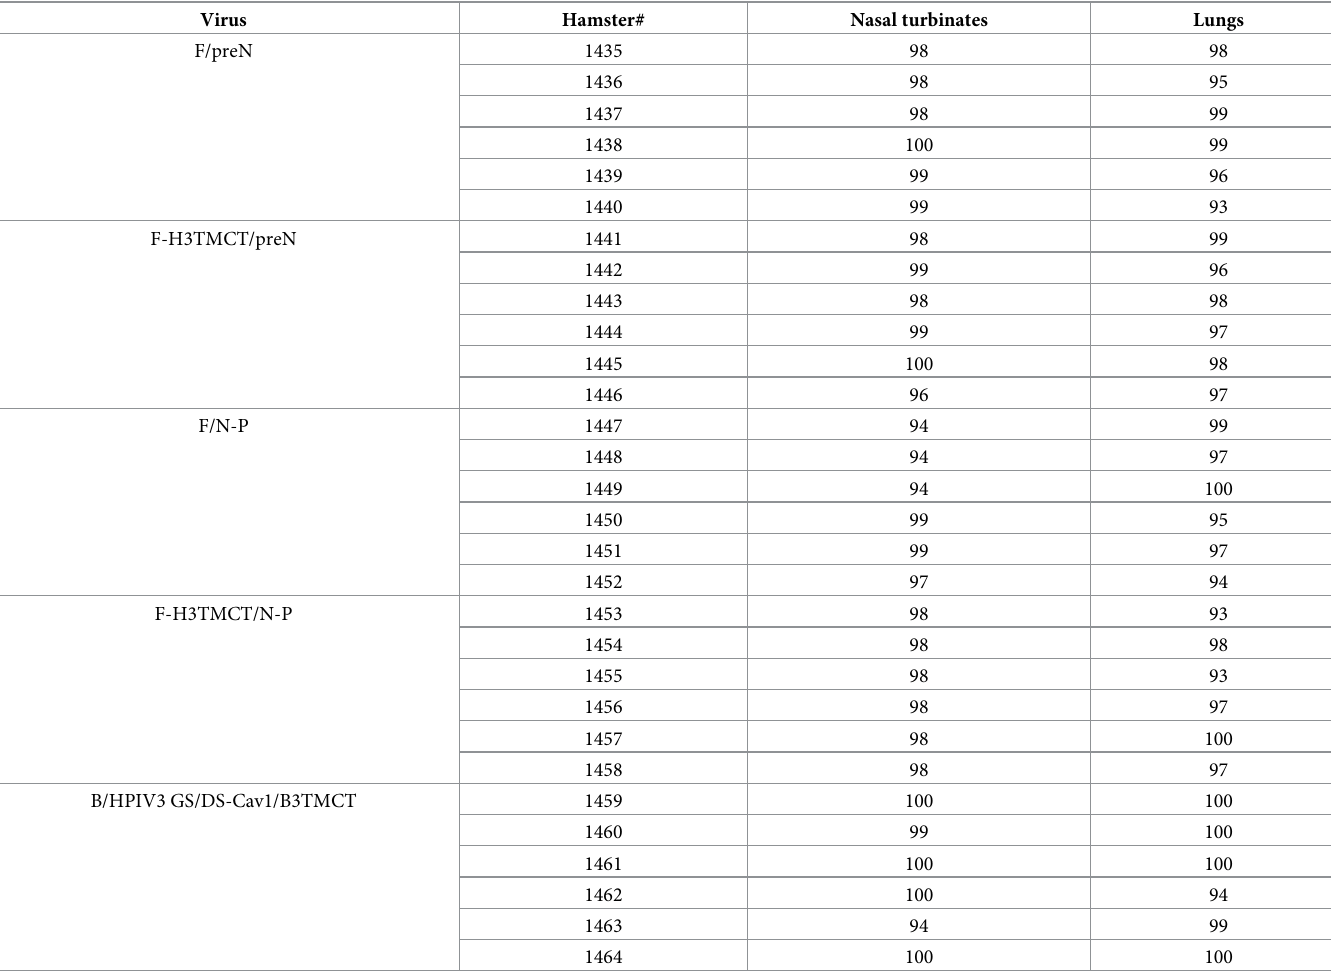
� Six-week old hamsters were inoculated IN with 10 5 TCID 50 of the indicated viruses in a 100 μ L volume. At 5 days post-infection, nasal turbinates and lungs were collected and tissue homogenates were analyzed by a double-staining immunofluorescence plaque assay on Vero cells to assess the stability of RSV F expression. The percentages of PFUs expressing RSV F, detectable by the conformationally-dependent anti-F MAbs, in the nasal turbinate and lung samples from each hamster are